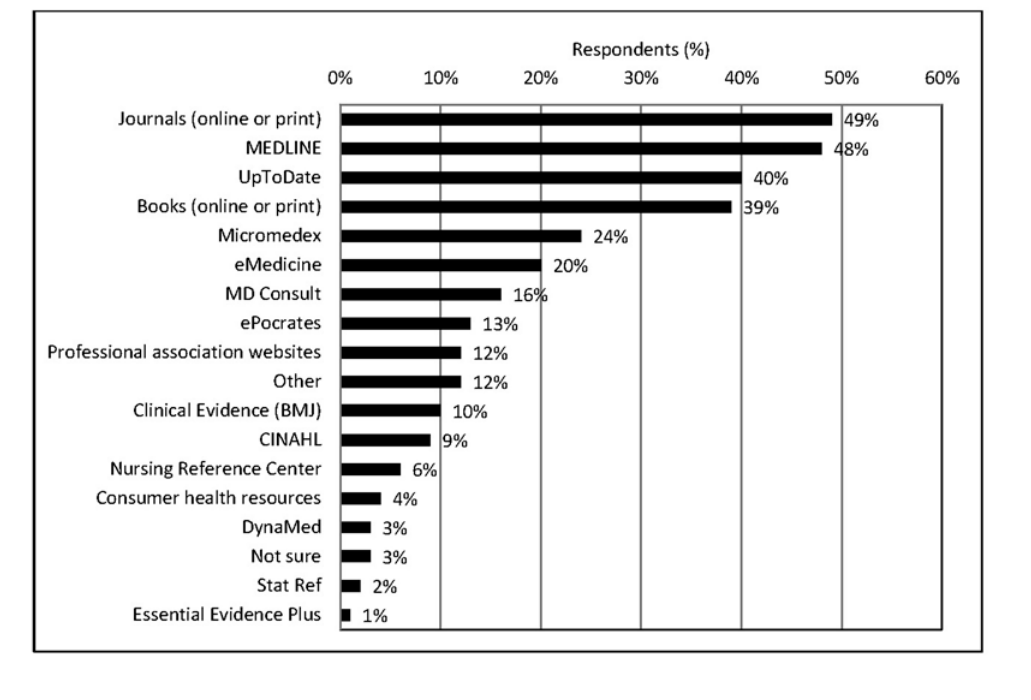
Figure 1 Information resources used